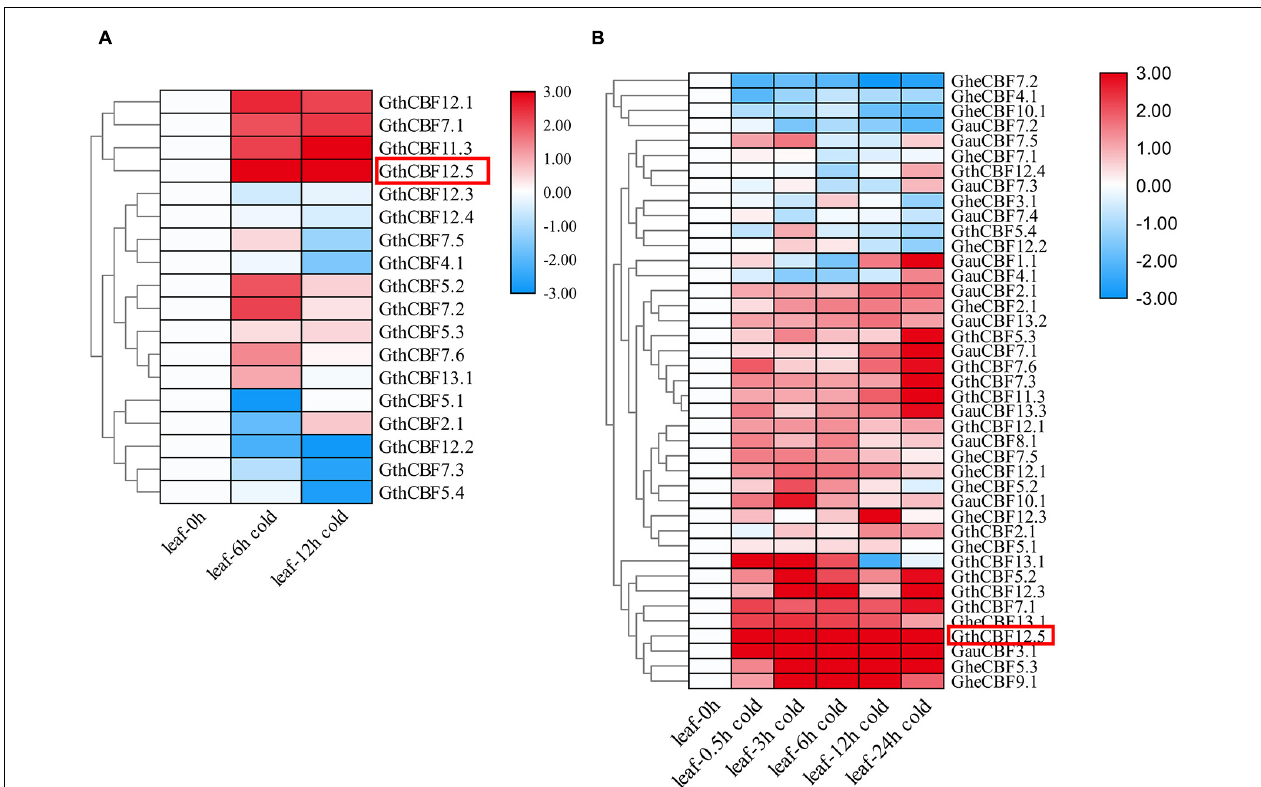
FIGURE 4 | RT-qPCR validations of transcript levels evaluated by RNA-Seq in G. thurberi under cold stress. (A) Heat map depicting log2 (fold change) of the transcription factor. (B) Heat map log2 (fold change) of the CBF genes expression under cold stress conditions. The samples were collected at 0, 0.5, 3, 6, 12, and 24 h for leaf tissues. Red: upregulated genes; blue: downregulated; black: none-expressed genes. Red Box denotes the key